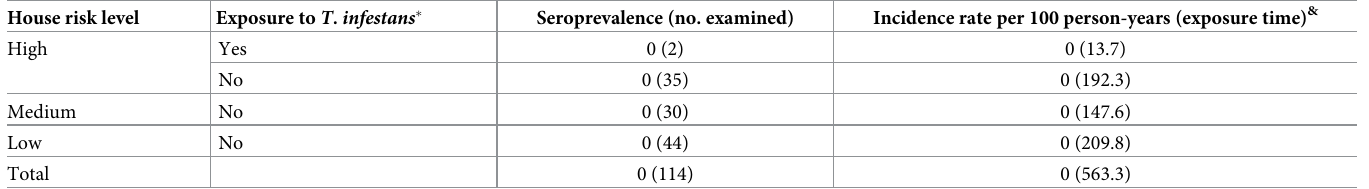
The large reduction in domestic transmission in Pampa del Indio is closely and directly related to the documented impacts of insecticide-based control actions on house infestation. The prevalence of domestic infestation with T . infestans plummeted over the first year after initial community-wide interventions and remained below 5% in Areas I-III over three to seven years after initial interventions, as determined jointly by timed-manual searches with a Table 3. Trypanosoma cruzi infection and incidence rate among seronegative human residents according to domestic exposure to T . infestans after initial serodiag- nosis, Pampa del Indio, 2017. House risk level Exposure to T . infestans � Seroprevalence (no. examined) Incidence rate per 100 person-years (exposure time)